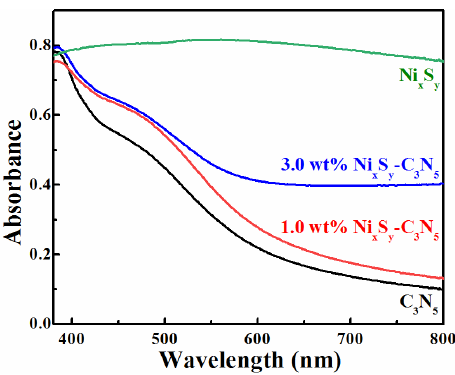
Figure 5. DRS spectra of Ni x S y , C 3 N 5 and Ni x S y -C 3 N 5